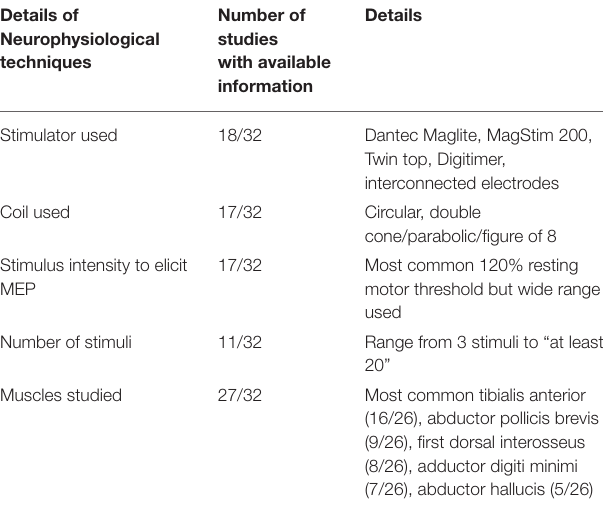
TABLE 1 | Details of neurophysiological techniques used in MEP